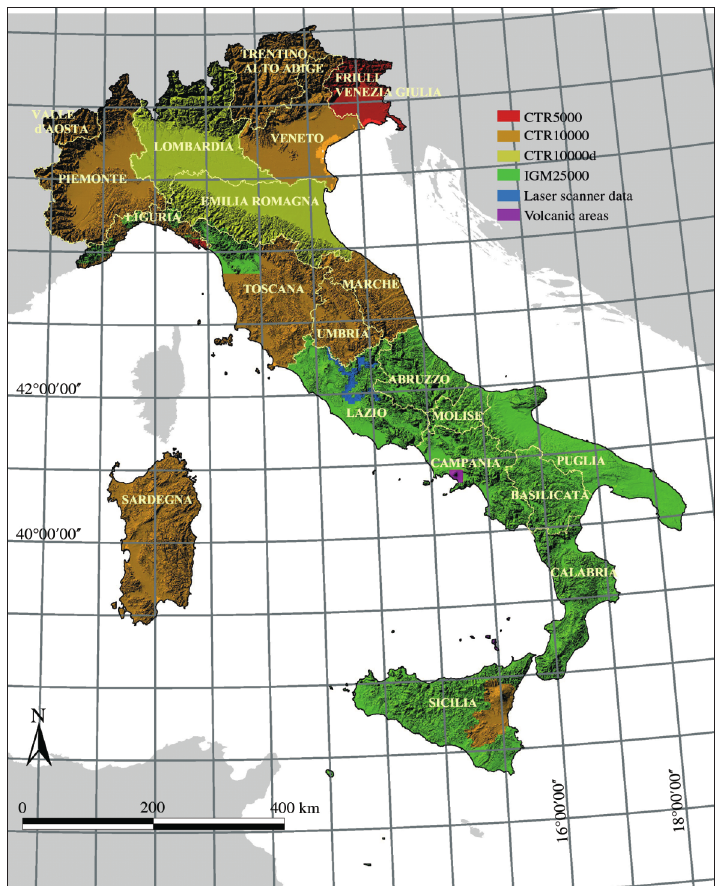
Fig. 2. The resolution of input data sources is not homogeneous over the Italian territory. Data resolution may even vary within some regions ( e.g. , Liguria